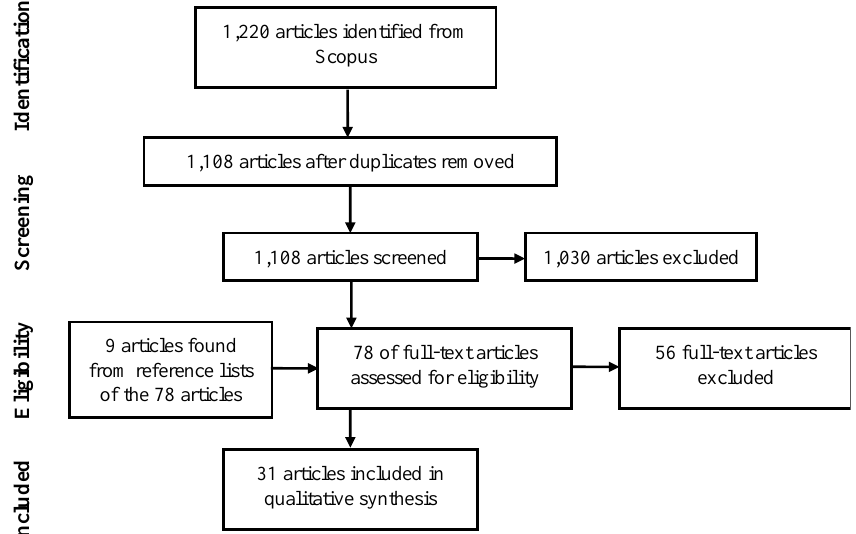
Figure 1. Phases of the systematic